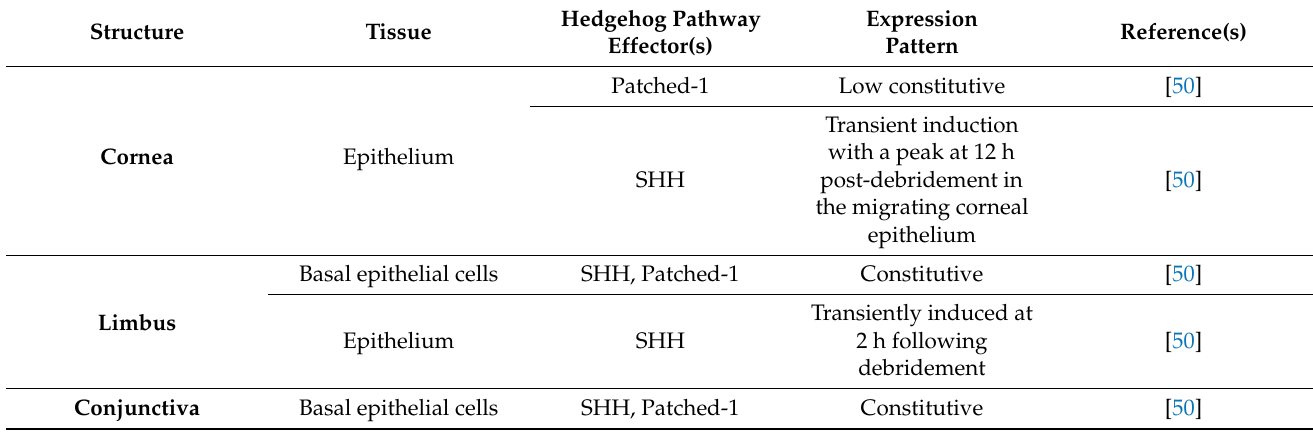
Table 2. Distribution of Hedgehog pathway effectors in the ocular surface of rats (SHH = Sonic Hedgehog).